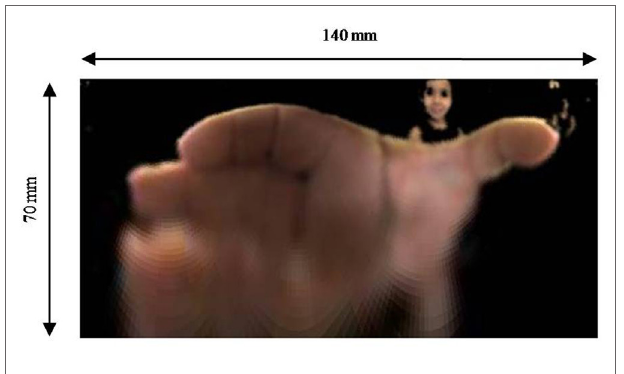
FIgURe 5 | panoramic view of Figure 4c